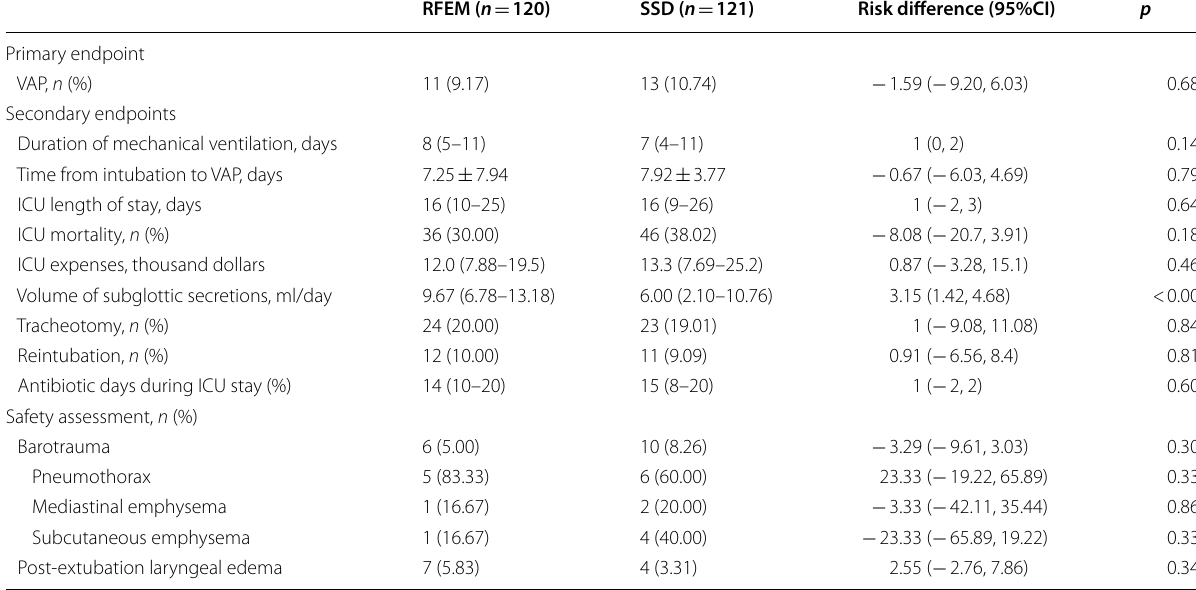
Qualitative indicators are expressed by the number of cases (percentage), and 95% CI is calculated by normal approximation method. If the quantitative index obeys normal distribution, it is expressed by mean standard deviation, and 95% CI is calculated by t -test method; if it does not obey normal distribution, it is expressed by ± median (upper quartile—lower quartile), and 95% CI is calculated by Hodges–Lehmann estimation method Secondary endpoints The time from endotracheal intubation to a VAP diagnosis was also similar between the two groups 1.59% and a one-sided upper 95% confidence limit of − (7.25 7.94 days, 7.92 3.77 days, respectively 6.03% ( p 0.683 for non-inferiority, Table 3). The cumu- ± ± = p 0.793). There was no significant difference in the lative rates of patients remaining VAP-free in the two = duration of mechanical ventilation, ICU mortality, groups using the Kaplan–Meier curve showed that the the length of ICU stay, or ICU cost between the two rate of VAP-free patients in the RFEM group was numer- groups. ICU mortality was 30.00% in the RFEM group ically higher than that of the SSD group but without a and 38.02% in the SSD group ( p 0.188) (Table 3). statistically significant difference (log rank test, p 0.364) = = (Fig. 2).